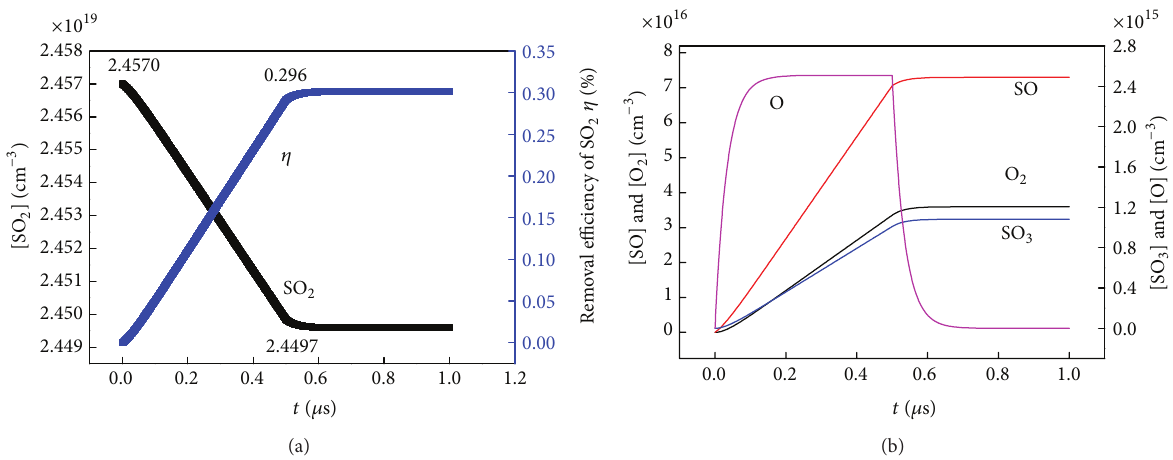
Figure 5: Without H 2 O vapor added, (a) time-resolved evolution of SO 2 concentration and the removal efficiency, and (b) time-resolved concentration evolution of SO, O 2 , O, and SO 3 .